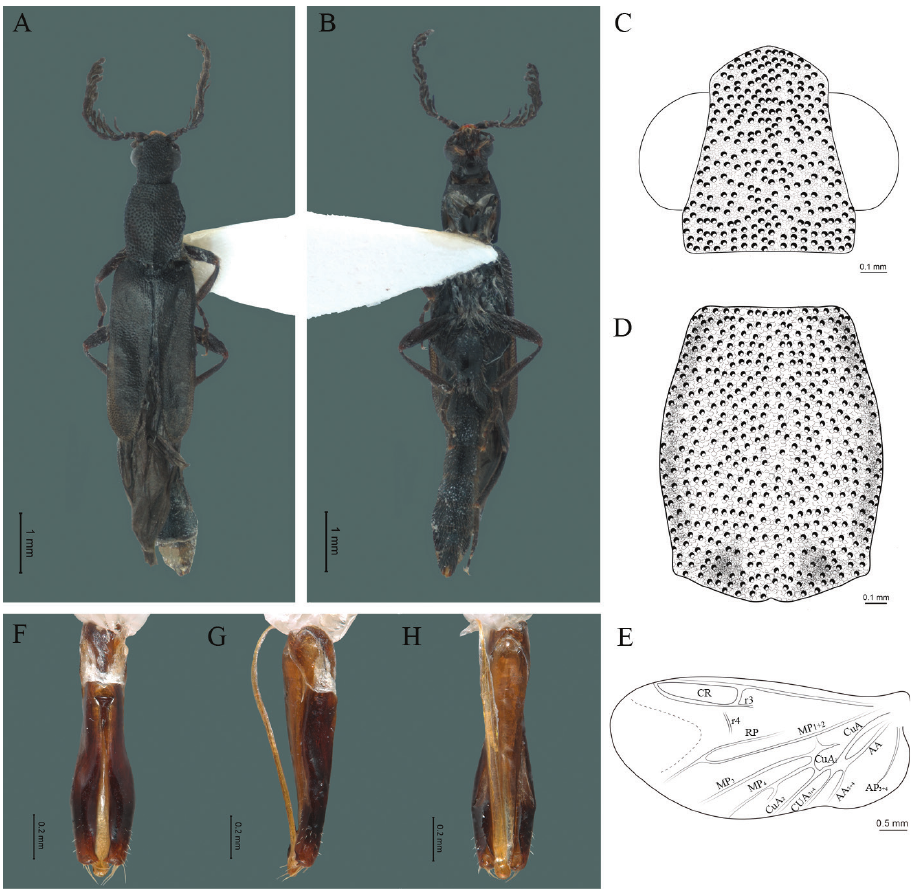
Figure 18. Cenophengus mboi Vega-Badillo et al. 2021, male. Habitus: A dorsal B ventral C head dorsal D pronotum dorsal E hind wing. Wing venation: CR = Radial Cell; r3 = radial 3 vein; r4 = radial 4 vein; RP = Posterior Radial vein; MP1+2 = Posterior Median vein; CuA = Cubital vein; AA and AP = Anterior and Posterior Anal veins. Aedeagus: F dorsal view G lateral view H ventral